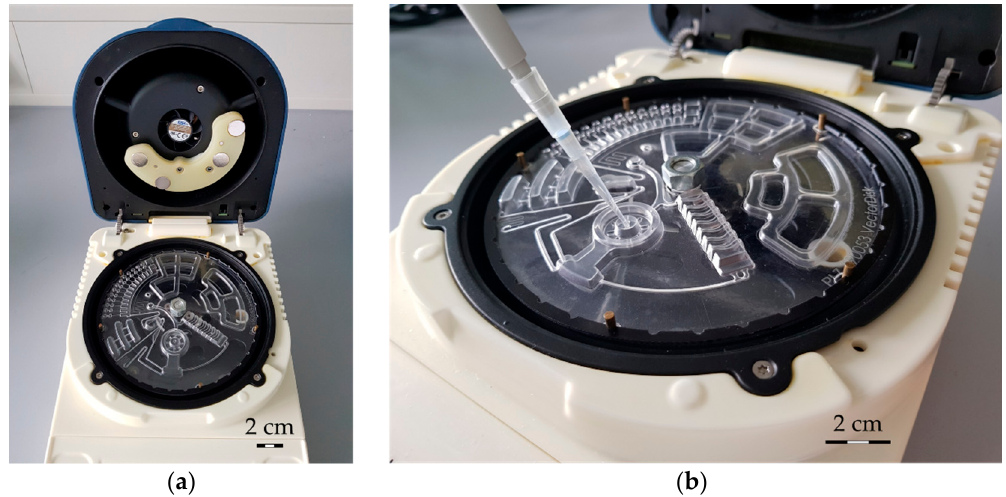
Figure 4. ( a ) The LabDisk Player instrument used in the two studies. ( b ) Pipetting the sample (diluted Figure 4. ( a )TheLabDiskPlayerinstrumentusedinthetwostudies. ( b )Pipettingthesample(dilutedlysate lysate or purified nucleic acid (NA)) into the VectorDisk. or purified nucleic acid (NA)) into the